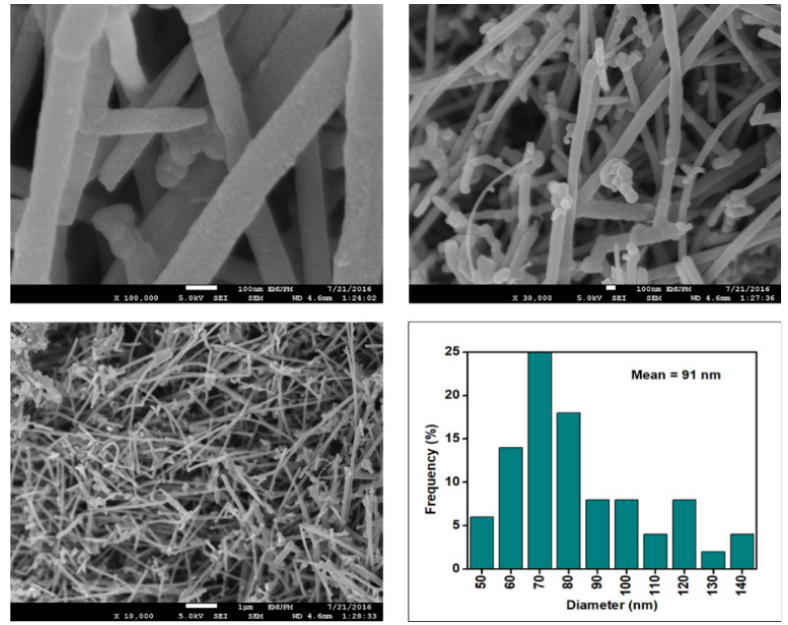
Figure 8. FESEM images of the CNF ‐ MB at 100, 30, and 10 resolutions and their corresponding diameter distribution histogram (mean diameter = 91 nm).